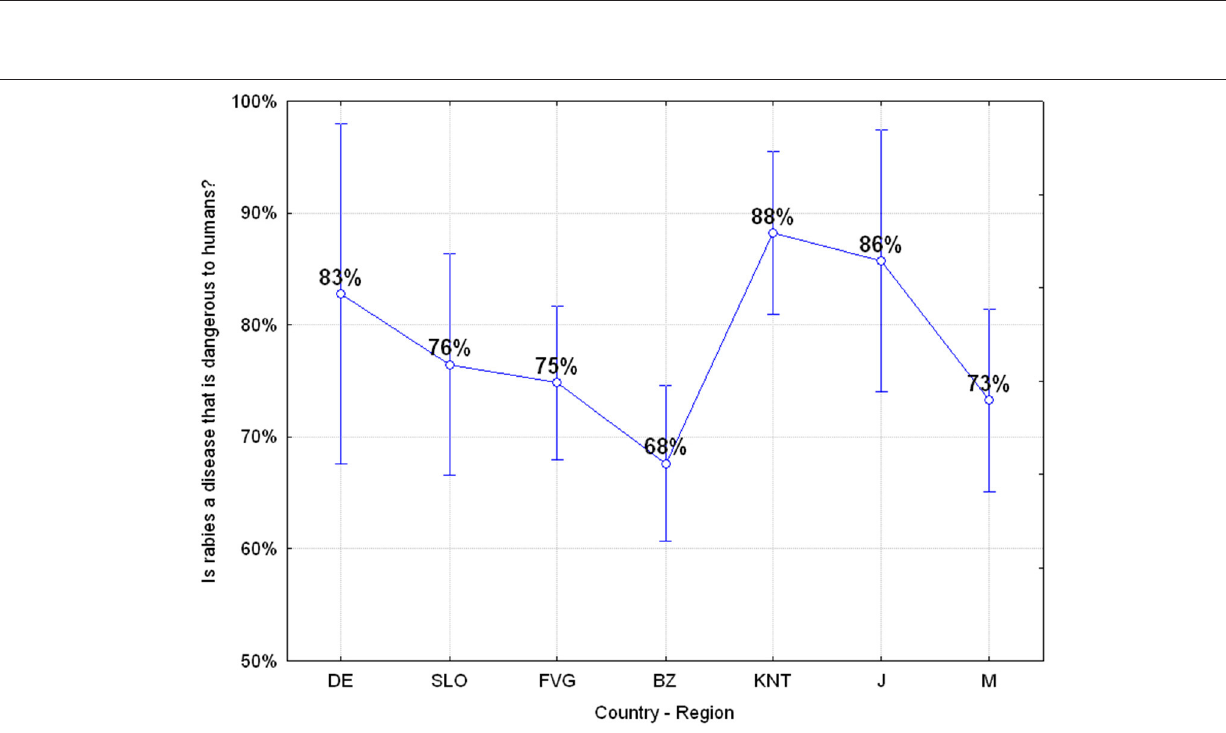
Frontiers in Public Health |